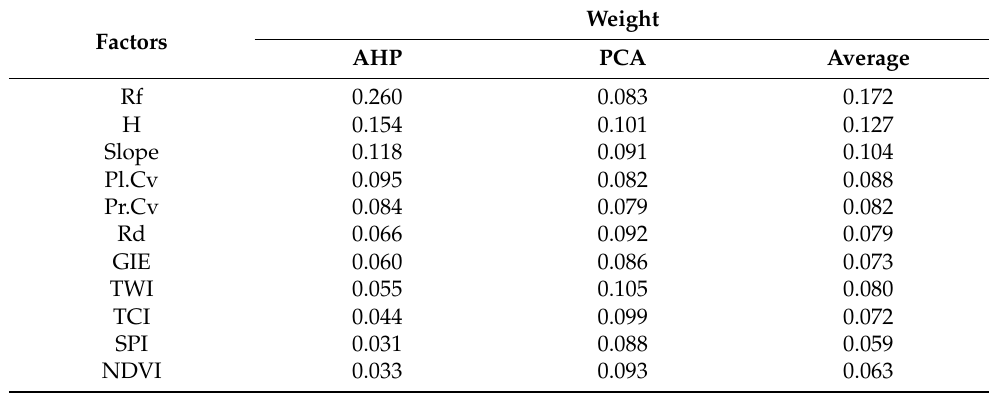
Table 3. Results of combined weights of each impact